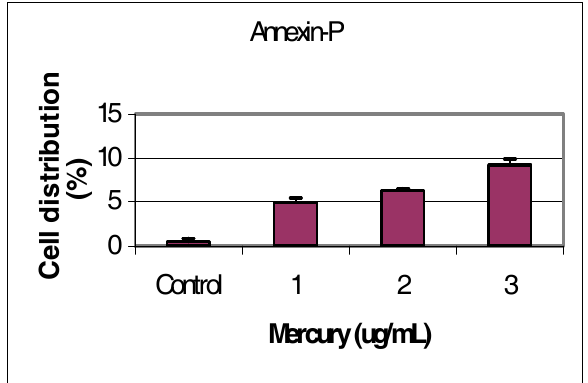
Figure 2: Proportion of Annexin V positive HepG in response to mercury exposure.